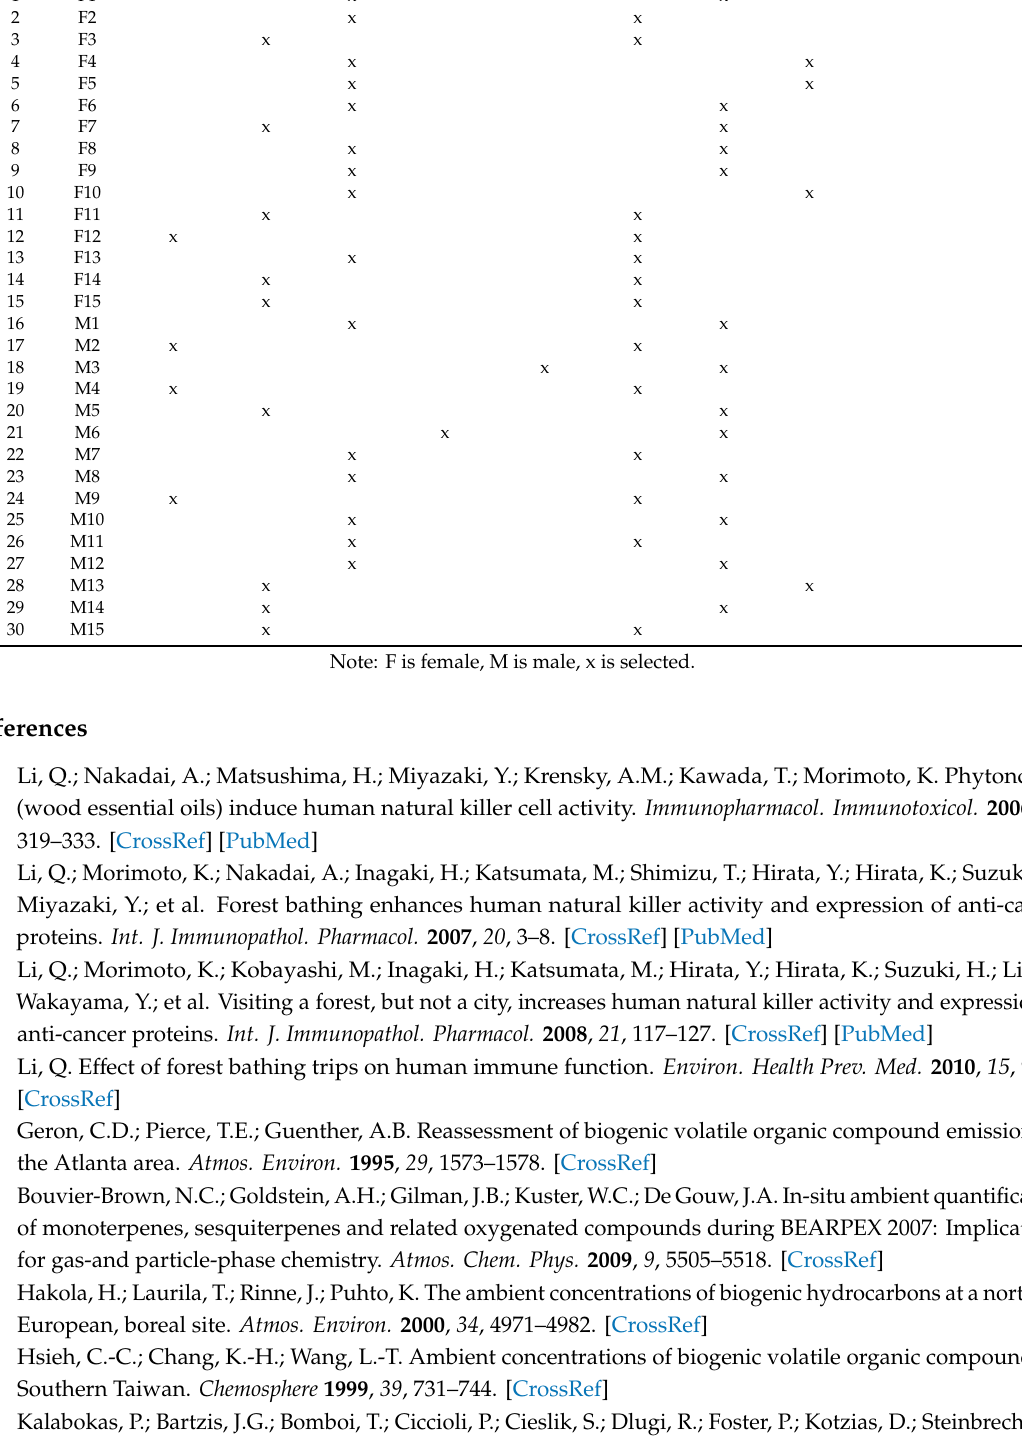
Table A3. Summary of participants’ answers to the questionnaire for the psychological test (Exp 2). Before inhaling MT After Inhaling MT No. Code Very Very Very Stable Normal Unstable Stable Normal Unstable Unstable Stable Stable x x 2